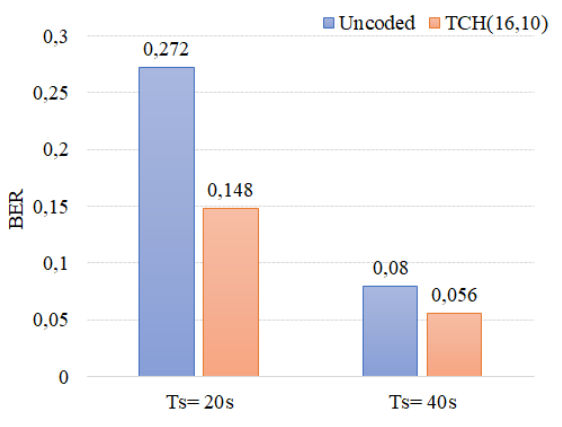
Figure 10. Uncoded and TCH(16,10) performance for T s = 20 s and T s = 40